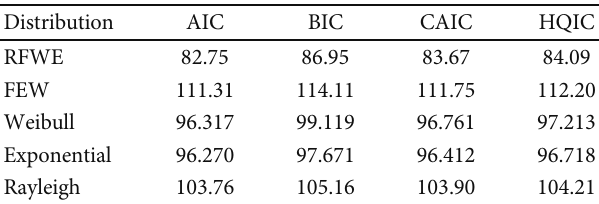
Table 2: Goodness of fi t results using AIC, BIC, CAIC, and